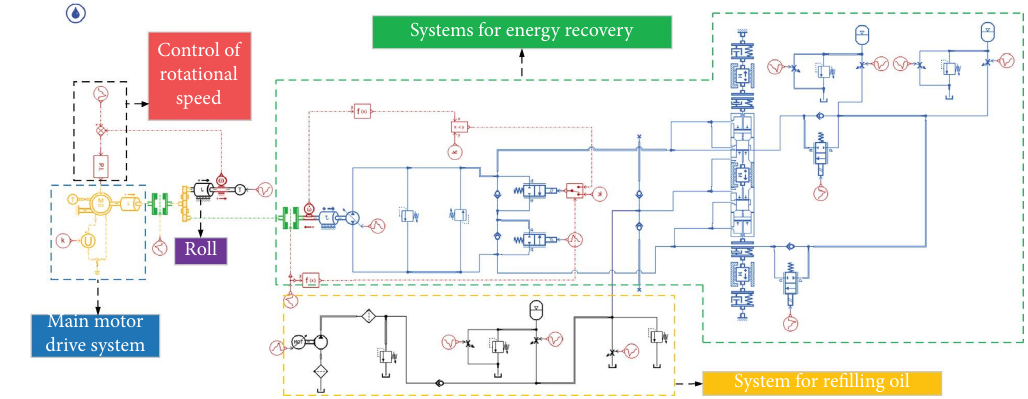
Figure 8: Energy recovery model based on the reversible rolling mill. Table 6: Basic parameters of the energy recovery model of reversible rolling